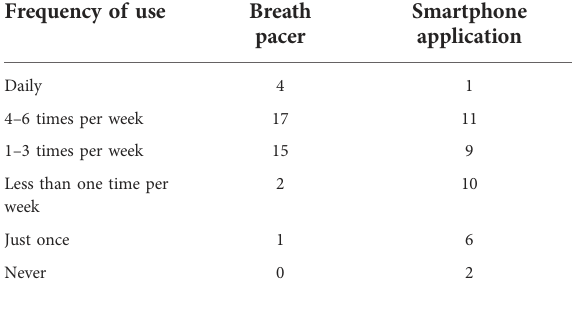
TABLE 1 Self-reported frequency of use of the breath pacer and accompanying application during the testing period. Entries represent the number of individuals ( N